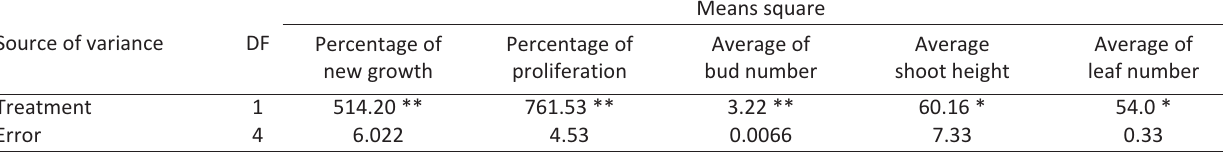
Table 4 ­ Evaluation of Gibberellic acid in MS medium along with PGRs and 500 mg/L cefixime on secondary growth traits